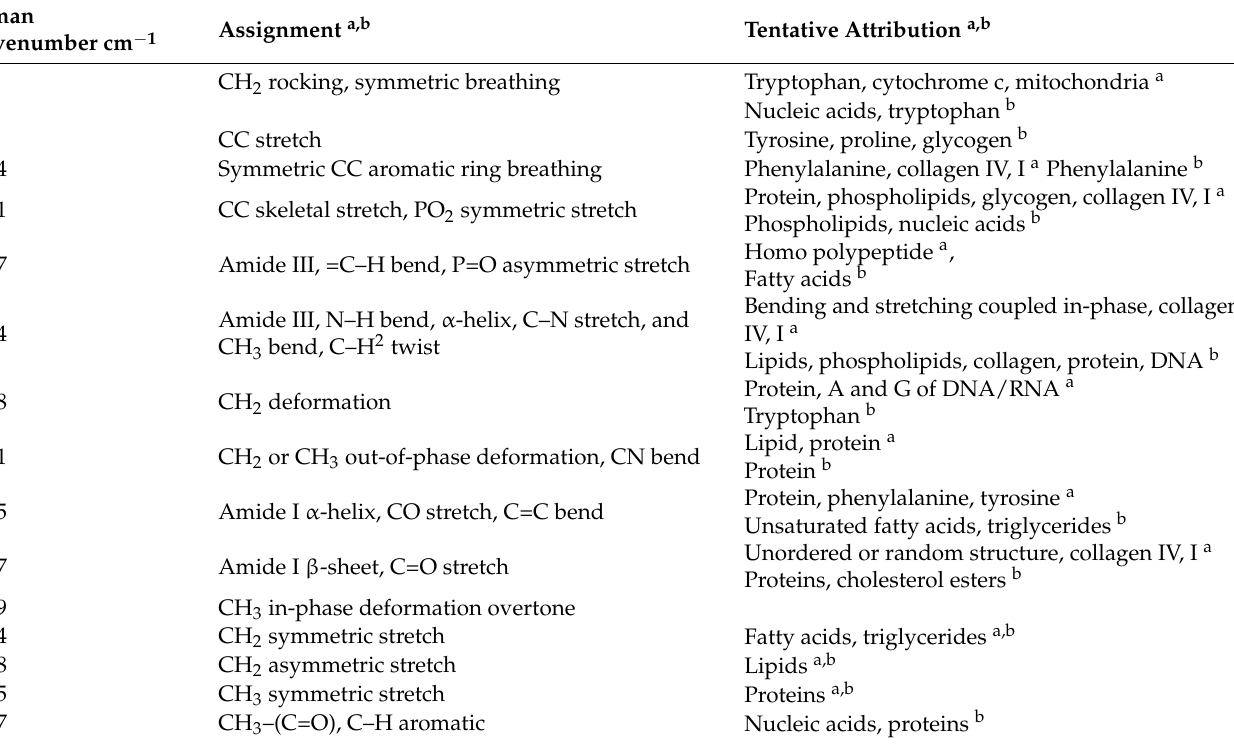
Table 1. Raman vibrational bands and their assignments with tentative